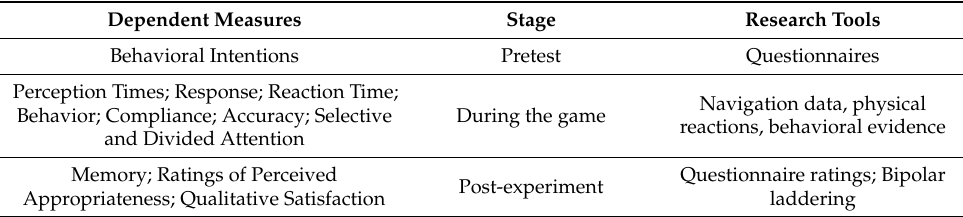
Table 1. Summary of the